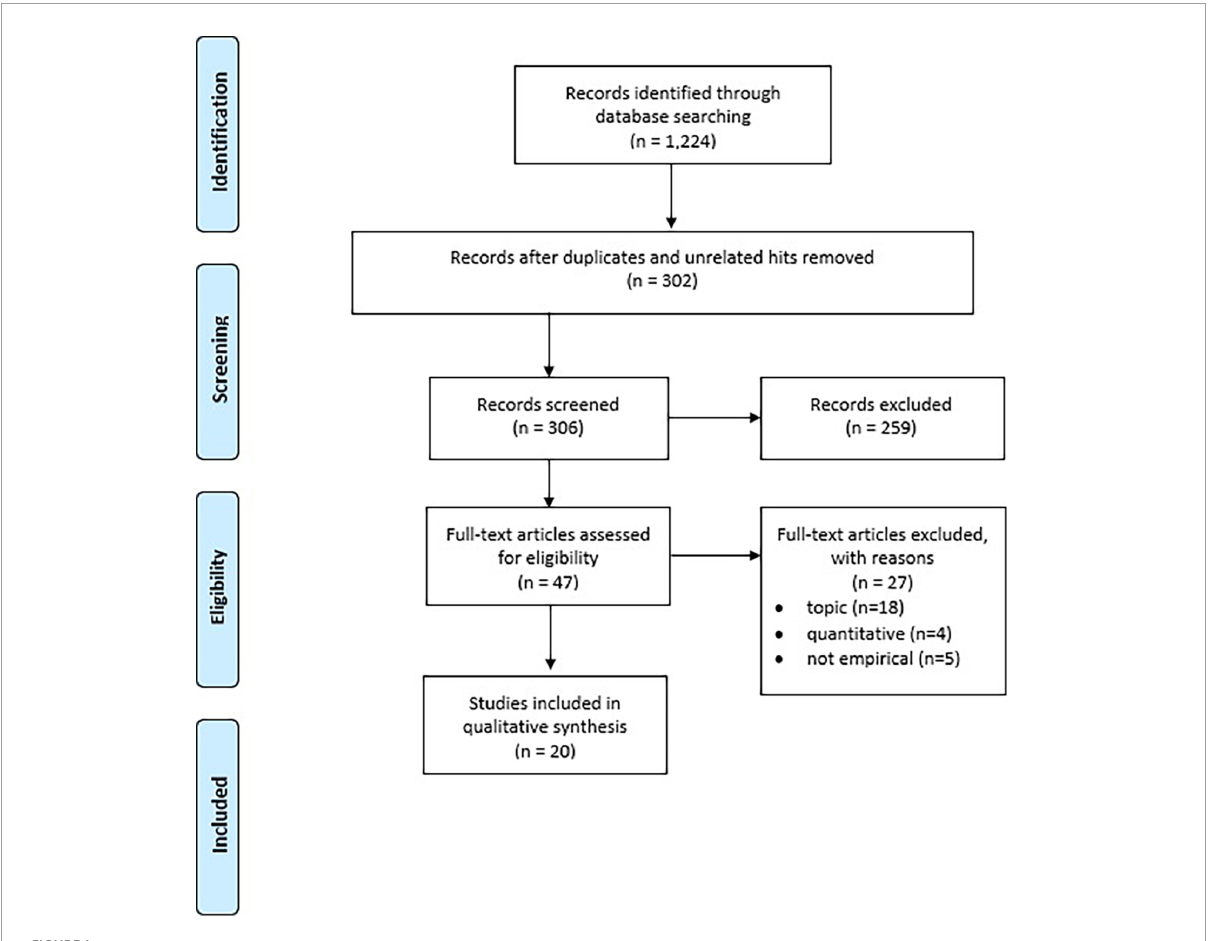
FIGURE1 Prisma flow